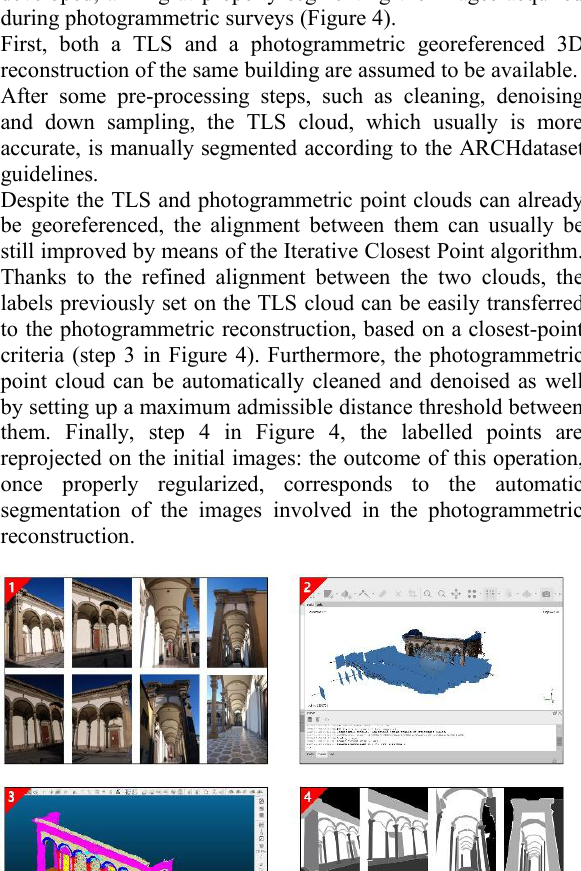
black the pixels classified in the same way, whereas pixels wrongly classified by the automatic labelling procedure are shown in white (Figure 5c).